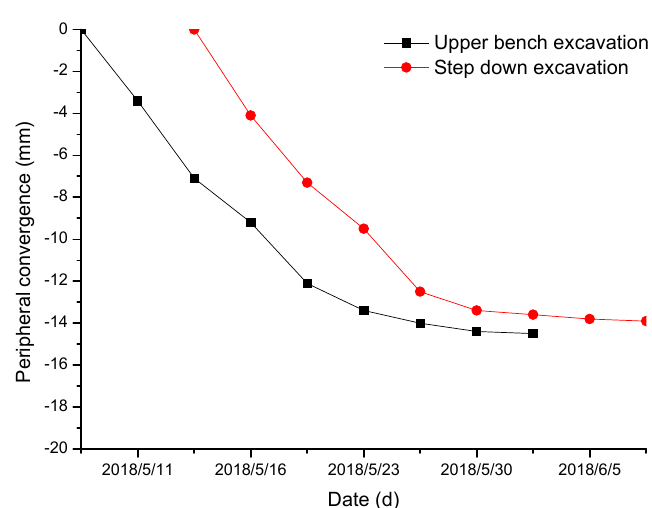
Figure 9. Time history curve of peripheral convergence.